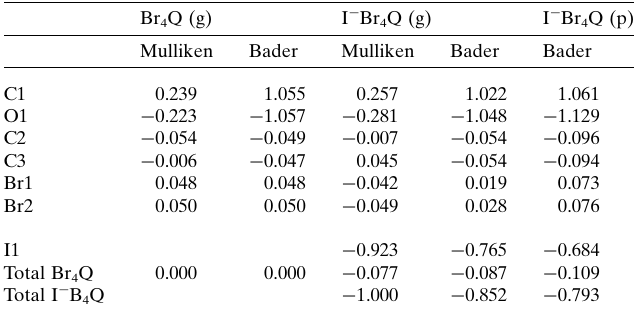
Table 4 Mulliken and Bader charges calculated in the gas-phase (g) as well as in a periodic system